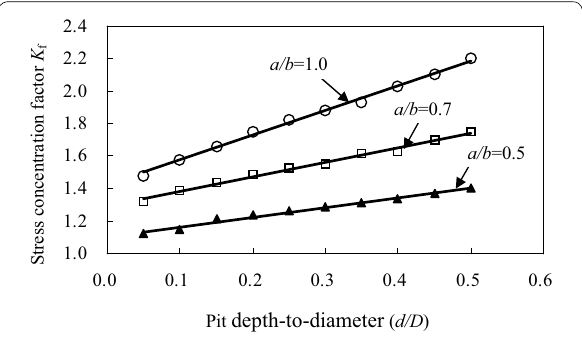
Fig. 6 Pit depth-to-diameter versus stress concentration factor.